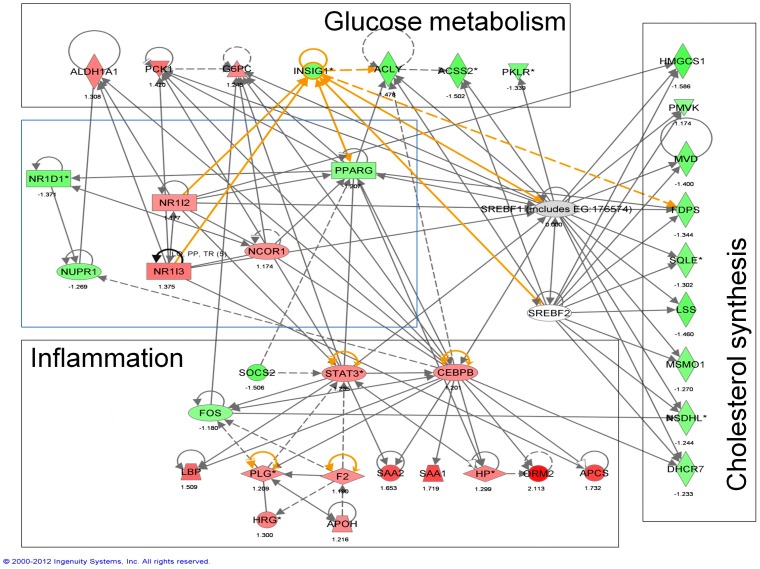
Summary of the gene expression patterns in liver.The figure displays some of the key molecular pathways affected by maternal diet (black boxes) with some representative genes. The blue box highlights some of the nuclear receptors that are differentially expressed according to the maternal diet and link Srebps and the most affected canonical pathways. Genes colored in green are over-expressed when the animals are born from LF fed dams (compared to animals born from HF fed dams), red genes that are under-expressed (with all animals being fed HF post-weaning).